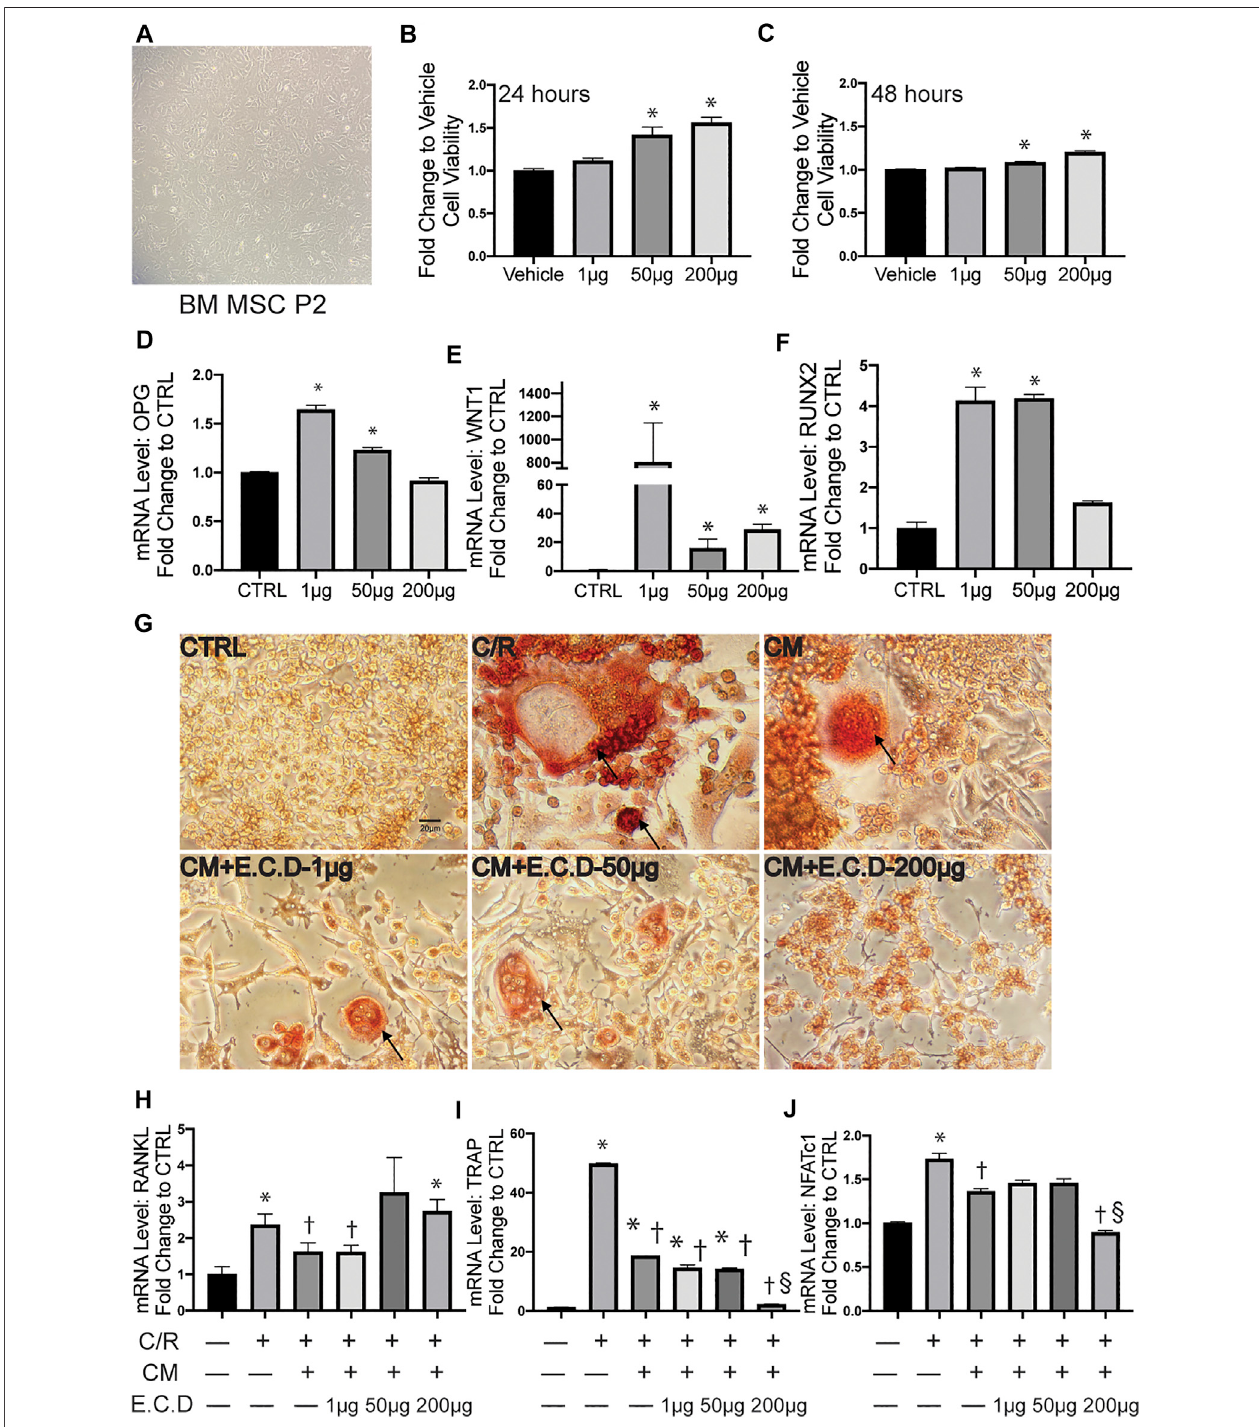
FIGURE5| E.C.D.extractspromotedOPGexpressionofMSCandregulatedparacrineeffectofMSCtoinhibitosteoclastogenesisofRaw264.7cells. (A) Themice bone marrow MSC was harvested and cultured for expansion. (B,C) The toxicity of E.C.D. extracts to MSC was assessed by CCK8 assay. The MSCs were cultured in 96-wellplate(Vehiclegroup), theE.C.D. extractswereaddedindifferentdosesof1 μ g/ml,50 μ g/ml,and200 μ g/ml (1 μ g,50 μ g,and200 μ ggroup,respectively). n =5 in each group, data were analyzed as mean ± SEM, * vs. Vehicle group. (D – F) The mRNA level of OPG, Wnt1, and Runx2 were analyzed byaddingdifferentdoses of E.C.D. extracts to MSC. n = 3 in each group. Data were analyzed as mean ± SEM, * vs. CTRL group, p < 0.05. ( G ) TRAP staining was assessed 5 days after C/R stimulation,theMSCCM,CMpretreatedwithE.C.D.extractsof1 μ g/ml,50 μ g/ml,and200 μ g/mlwereaddedwithC/R.